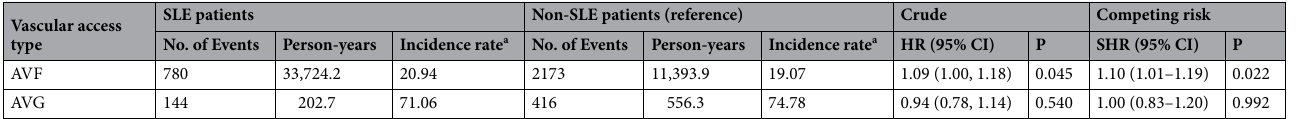
Table 3. Incidence rates and risks of AVF/AVG dysfunction in SLE and non-SLE patients. AVF arteriovenous fistula, AVG arteriovenous graft, SLE systemic lupus erythematosus, HR hazard ratio, SHR subdistribution hazard ratio, CI confidence interval. a Per 100 person-years.